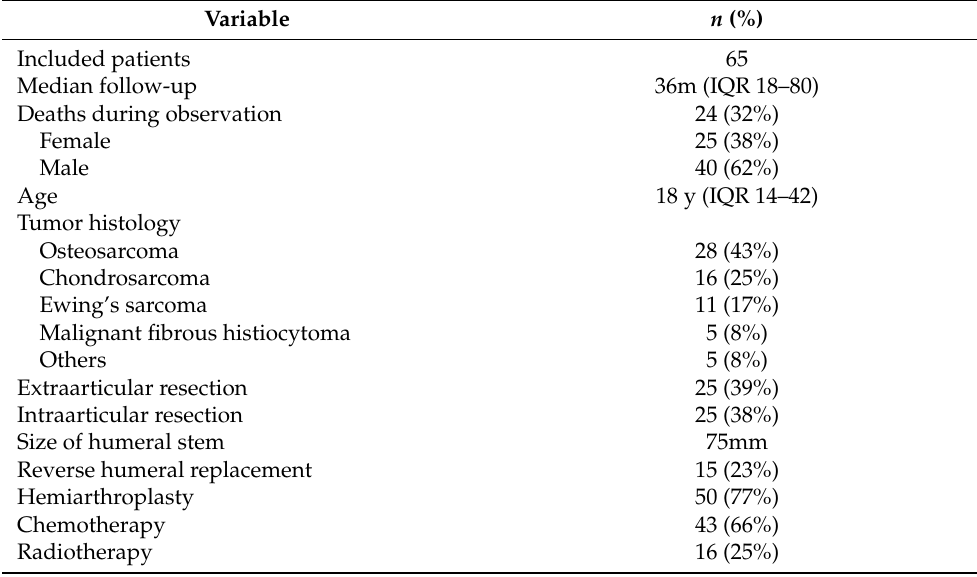
Table 1. Patient demographics and study specifics.